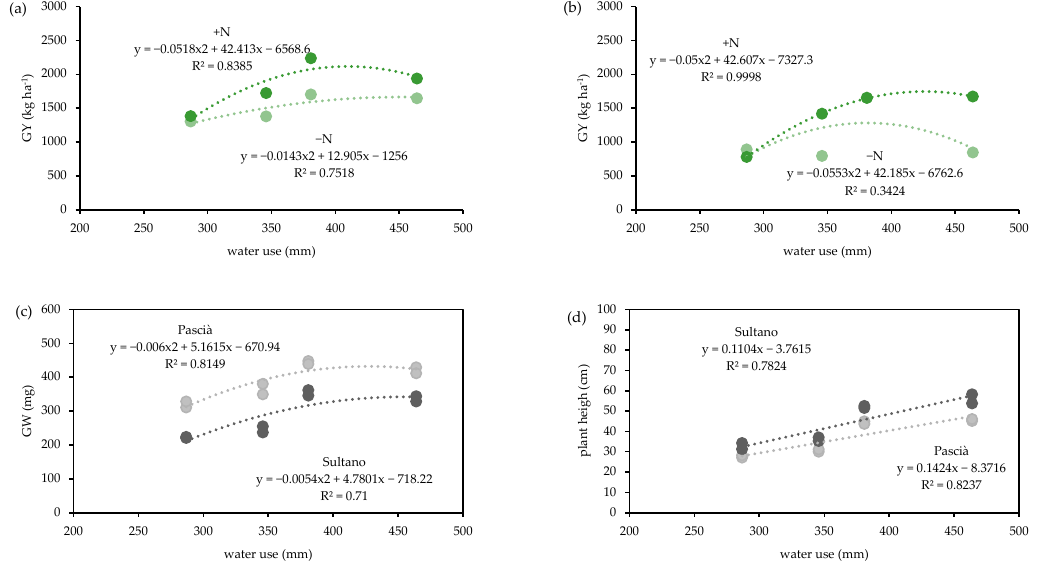
Figure 3. Relationship between water use with grain yield (GY) for at 0 kg ha − 1 of N (light green) and 40 kg ha − 1 of N (deep green) in Pascià ( a ) and Sultano ( b ) chickpea genotypes and with grain weight ( c ) and plant height ( d ). Chickpea genotypes Pascià and Sultano are reported in deep grey and light grey, respectively.